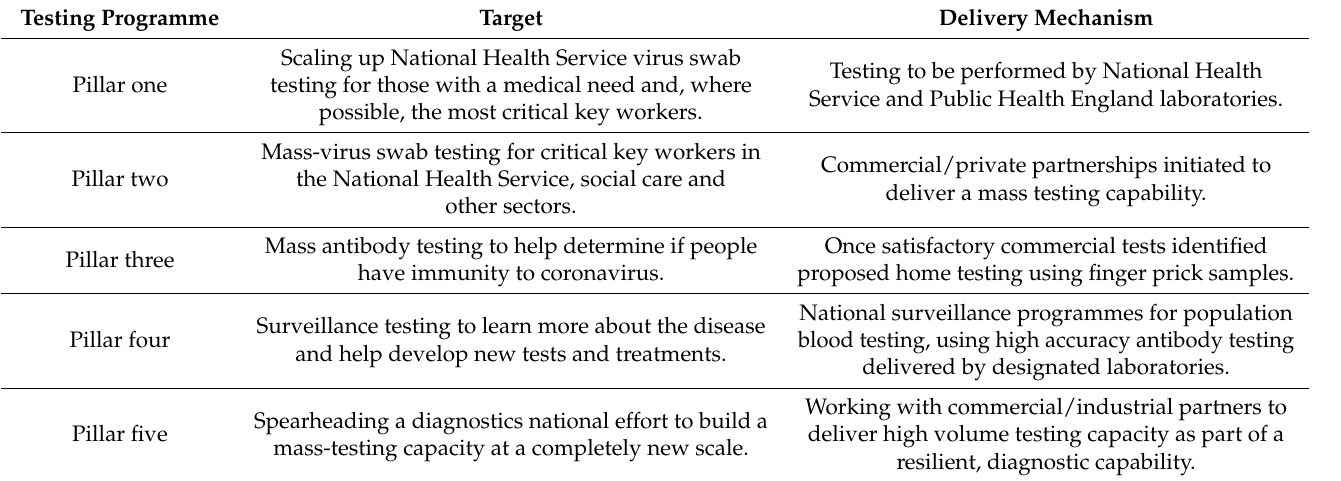
Table 1. Components of the English national testing strategy for COVID-19 as described April 2020